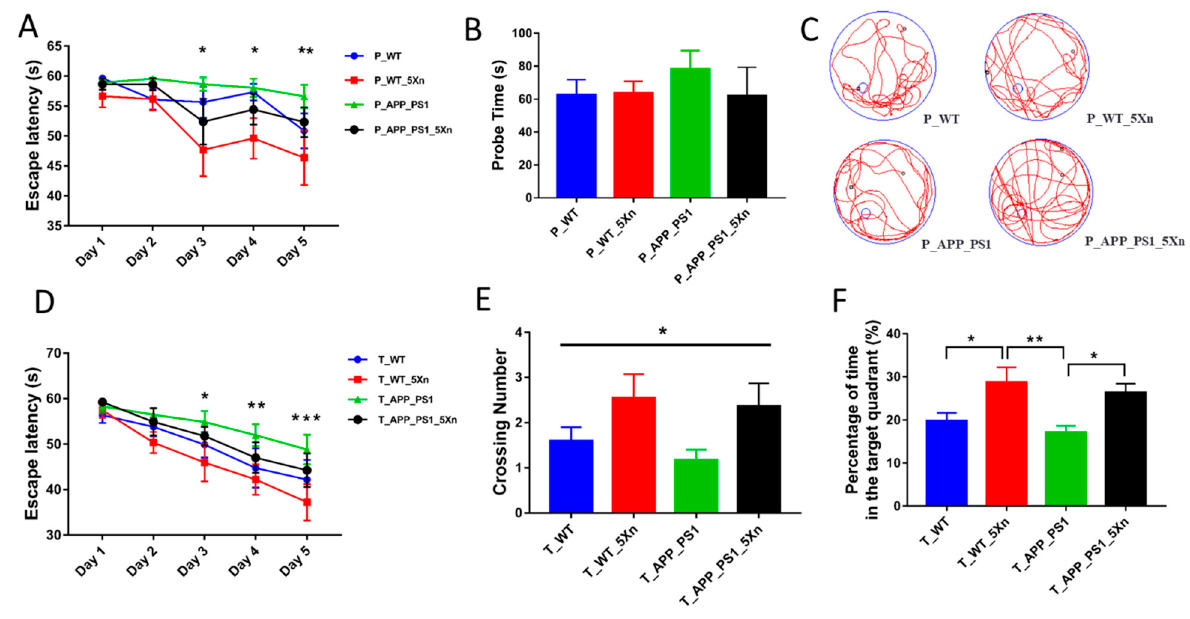
Figure 1. Xn improves behavioral performances of APP/PS1 mice. ( A – C ) Results of MWM test in the prevention experiment ( n = 7–11 per group). ( D – F ) Results of MWM test in the therapy experiment ( n = 10–14 per group). ( A ) Escape latency during platform trial test in the prevention experiment. As the learning time increased, the Xn-treated mice showed better memory compared to wild-type (WT) or APP/PS1 mice (* p < 0.05, ** p < 0.01, analyzed by repeated measures ANAVA). ( B ) Probe time of four groups in probe trial test. There was no difference in probe time among groups ( F = 0.788, p = 0.538). ( C ) Representative tracing graphs of four groups in probe trial test. ( D ) Escape latency during platform trial test in the therapy experiment. As the learning time increased, the Xn-treated mice showed better memory compared to WT or APP/PS1 mice (* p < 0.05, ** p < 0.01, *** p < 0.001, analyzed by repeated measures ANAVA). ( E ) Crossing number of four groups in probe trial test. Significant difference was found in crossing number among groups (* p < 0.05, analyzed by two-way ANOVA). ( F ) Quantitative analysis of time spent in the target quadrant. Compared with WT or APP/PS1 mice, the Xn-treated mice showed better spatial recognition (* p < 0.05, ** p < 0.01, analyzed by two-way ANOVA). Error bar, SEM.